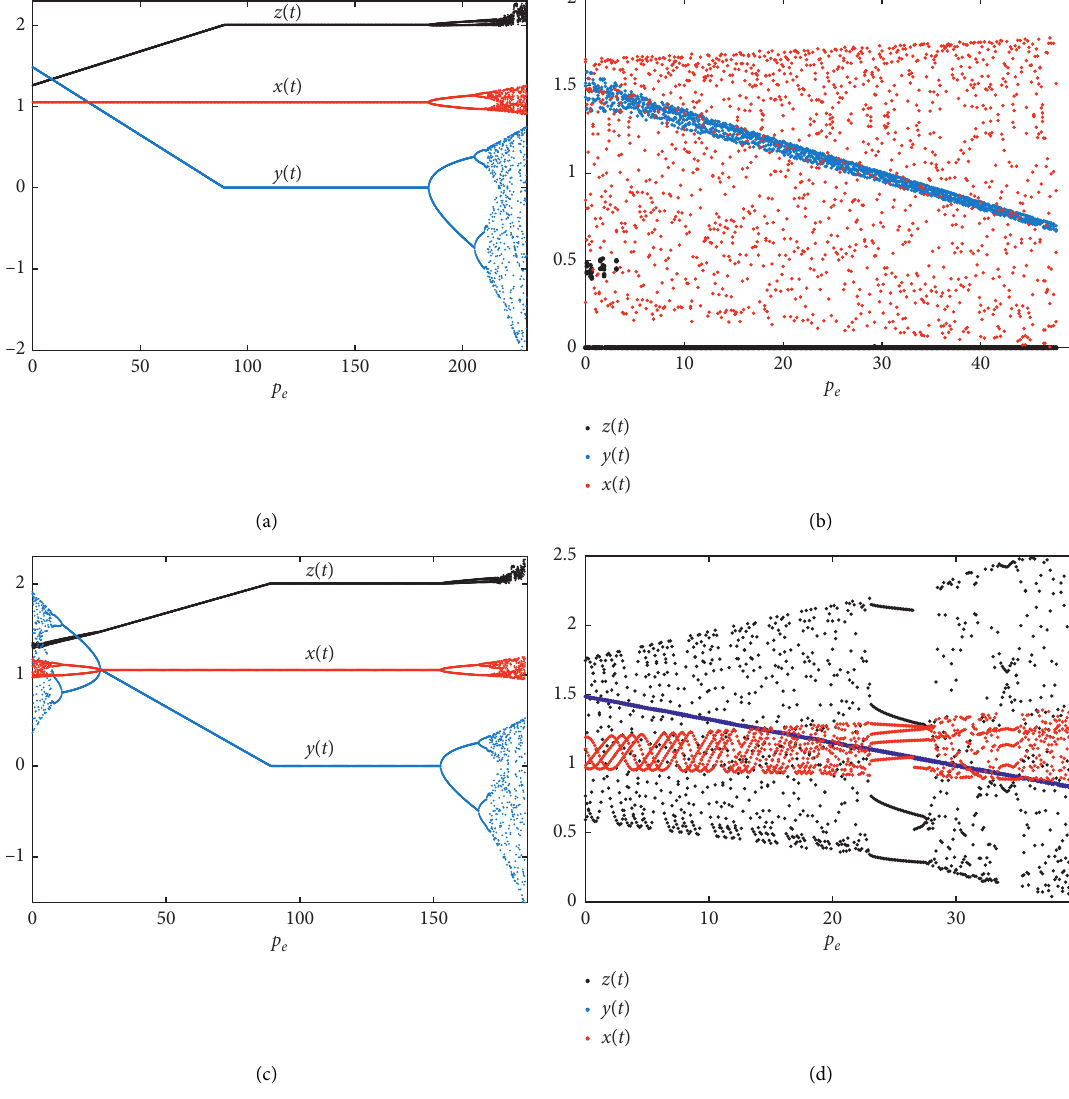
� 0 . 7 , α � 0 . 21 , and α 2 � 10. 3